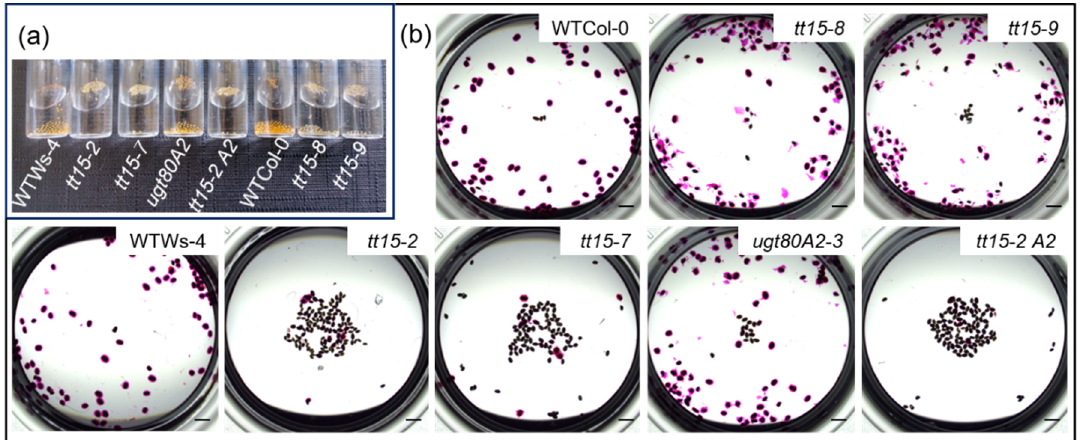
Figure 1. tt15 seeds remain buoyant because they do not release mucilage. ( a ) Seed buoyancy was examined for 200 seeds of tt15 or ugt80A2-3 mutants in Ws-4 or Col-0 accessions by comparing to wild-type seeds after imbibition in water for 10 min. ( b ) direct ruthenium red staining of 100 seeds per genotype. Bars = 1 mm. Wild-type, WT, tt15-2 ugt80A2-3 , tt15-2 A2 . Similar results were obtained with seed lots from 3 biological replicates/genotype.